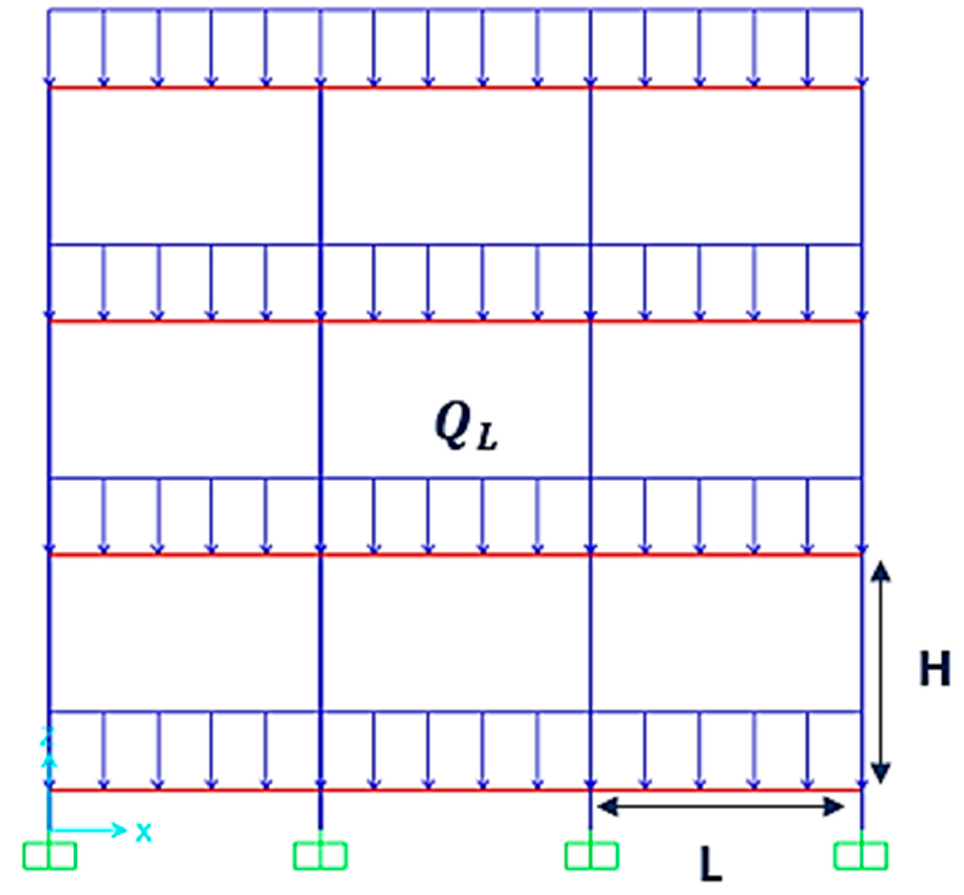
Figure 8. Schematic view of input parameters used in the sensitivity analysis.